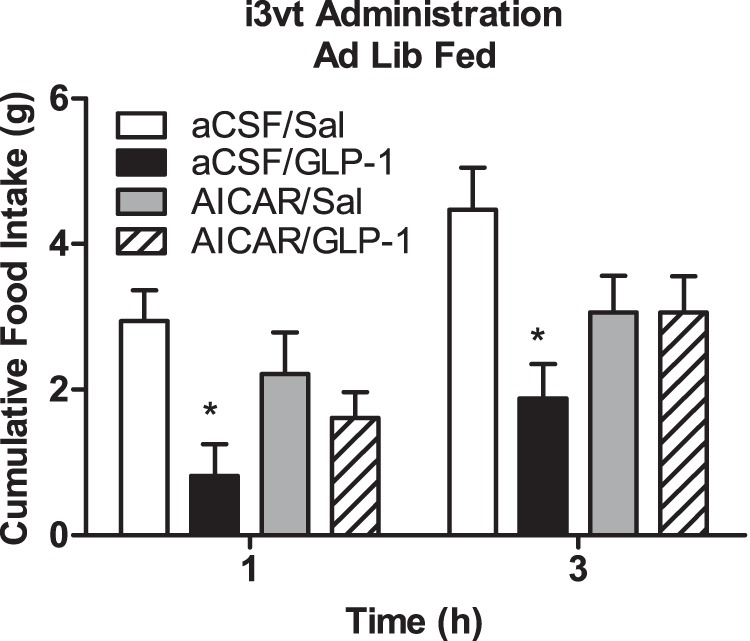
The impact of AICAR on GLP-1-induced anorexia.Animals given CSF+GLP-1 had significantly reduced food intake at 1 and 3 h compared to all other groups (*p<0.05) and AICAR blocked this effect. Open bar, i3vt artificial cerebral spinal fluid+ i3vt saline; closed bar, i3vt artificial cerebral spinal fluid+i3vt GLP-1; gray bar, i3vt AICAR+ i3vt saline; hatched bar, i3vt AICAR+i3vt GLP-1.